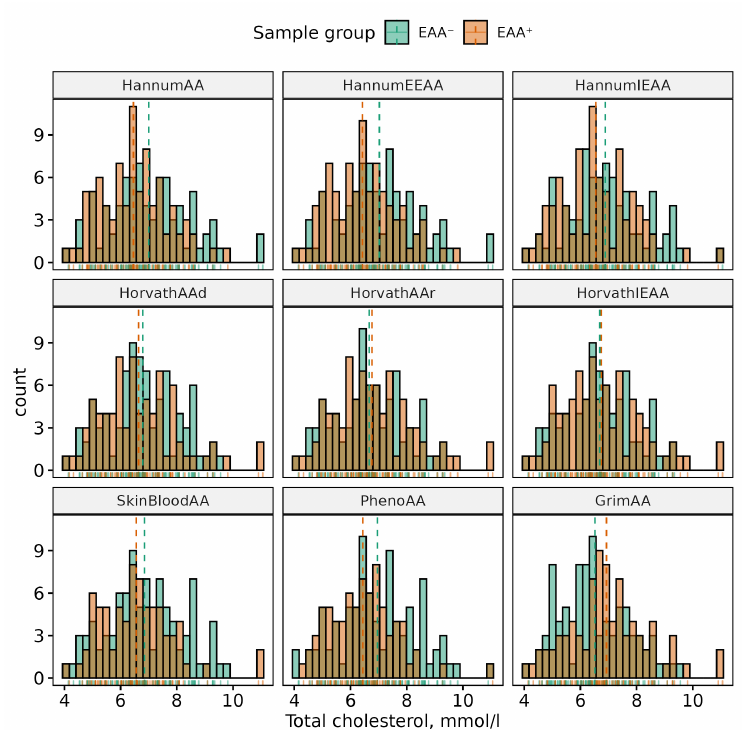
Figure A9. Histograms of distributions of TC levels in females in EAA + and EAA − groups. Dashed lines correspond to the group means.